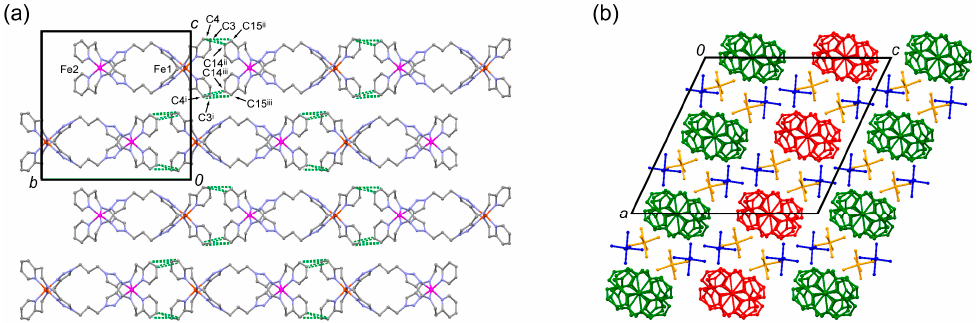
Figure 4. ( a ) Intermolecular interactions of 1·AsF 6 at 120 K. Adjacent complex-cations [Fe II2 (L2 C3 ) 2 ] 4+ with the same chirality are connected by intermolecular π – π interactions (green dotted line) to form the homochiral 1D chain structure along the b -axis. Symmetry operations: (i) − x, y, 3/2 − z; (ii) x, − 1 + y, z; (iii) − x, − 1 + y, 3/2 − z; ( b ) Packing diagram of 1·AsF 6 at 120 K viewed along the ac plane. Δ – Δ -[Fe II2 (L2 C3 ) 2 ] 4+ and Λ – Λ -[Fe II2 (L2 C3 ) 2 ] 4+ enantiomers are represented by green and red colors, respectively. Cationic 1D chains with the opposite chirality running along the b -axis exist in a crystal